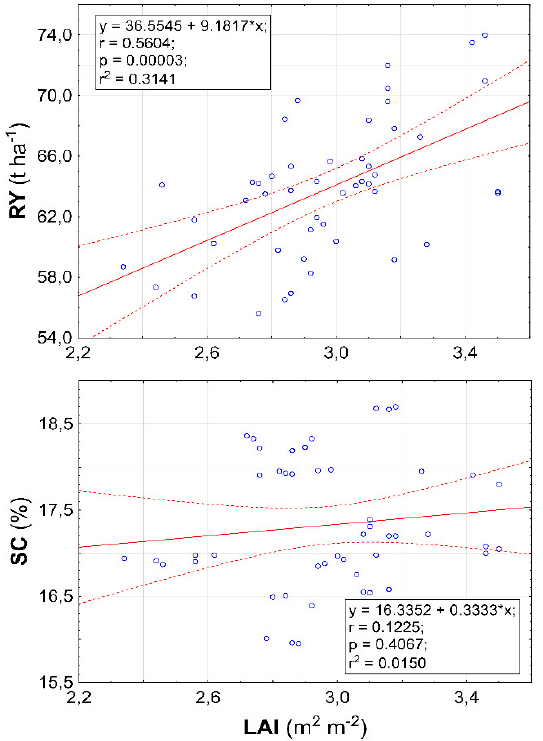
Figure 10. Relationships between leaf area index (LAI) and root yield (RY), and sugar content (SC), respectively. Solid lines represent the linear relationship between parameters. Linear equations, correlation coefficient, probability, and regression are inserted inside the figures.